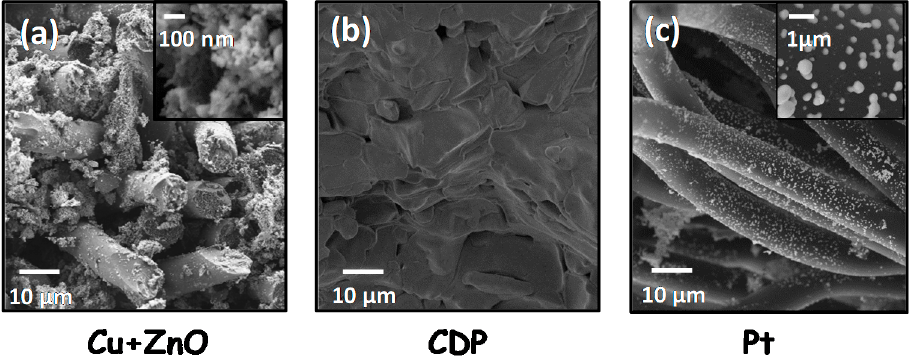
Figure 6. FE-SEM micrographs of the Cu + ZnO based electrode ( a ), dense CDP electrolyte ( b ) and Pt based electrode ( c ).